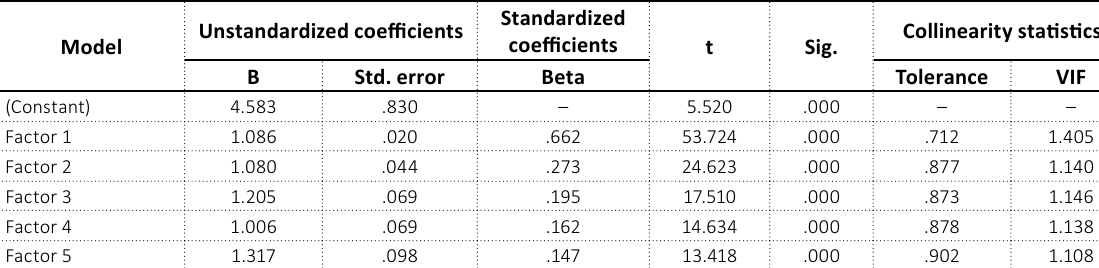
Table A4. Statistical output for the challenges Model